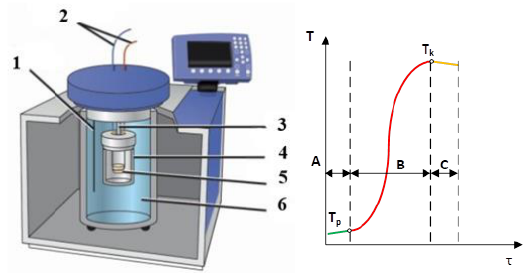
Fig. 3. Schematic diagram of the pressure calorimeter, as well as the calorimetric curve of water temperature variability during the determina- tion of the fuel heat of combustion: A, B, C – characteristic measurement periods, respectively: initial, main and final (A ≈ B), 1 – thermometer, 2 – electrodes: insulated and with ignition wire, 3 – tubes: oxygen inlet and exhaust outlet, 4 – calorimetric bomb, 5 – crucible, 6 – water jacket [20]